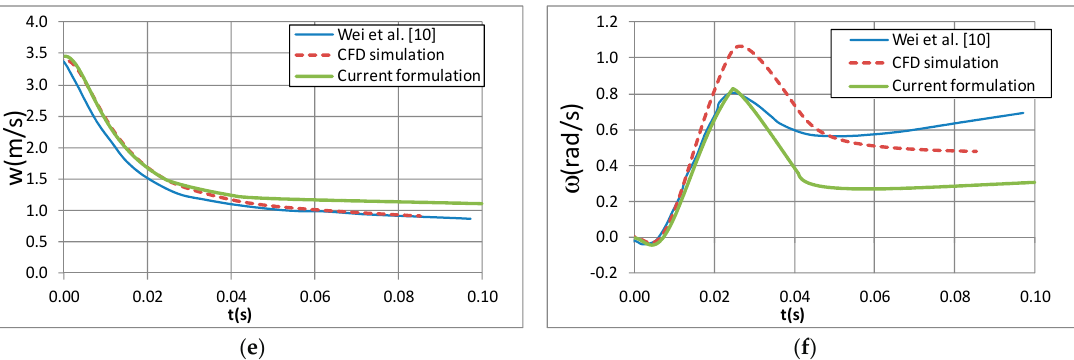
Figure 16. Impact with three degrees of freedom, m = 293 kg, h = 0.61 m, β = 20°, φ 0 = 5°, Vcg = 0.216 m, and I xx = 10.95 kg.m 2 . ( a ) Horizontal acceleration during the impact. ( b ) Vertical acceleration during the impact. ( c ) Angular acceleration during the impact. ( d ) Horizontal velocity during the impact. ( e ) Vertical velocity during the impact. ( f ) Angular velocity during the impact.